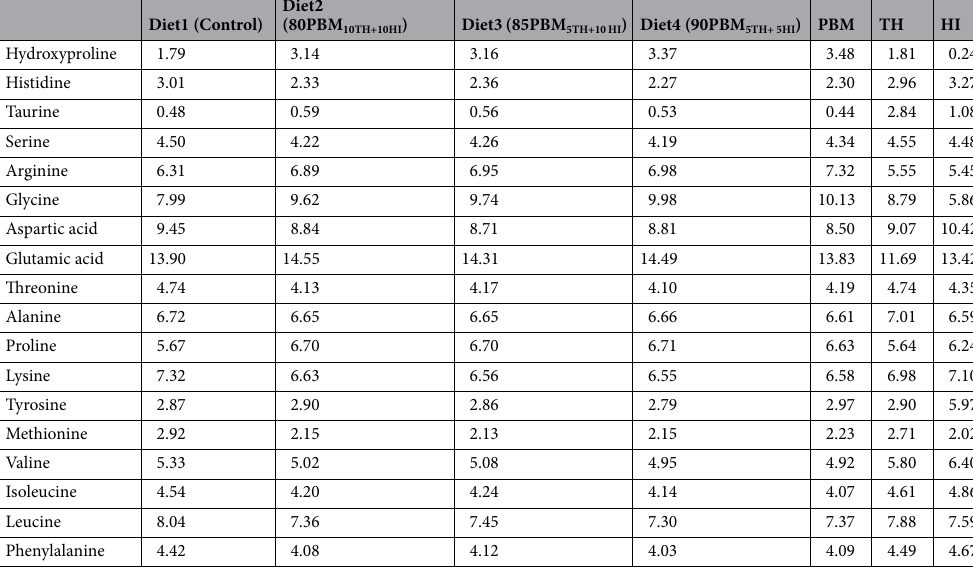
Table 2. Amino acid composition (g/100 g DM) of PBM-based diets, supplemented with TH and HI larvae meal and different ingredients including PBM, TH and HI larvae meal.